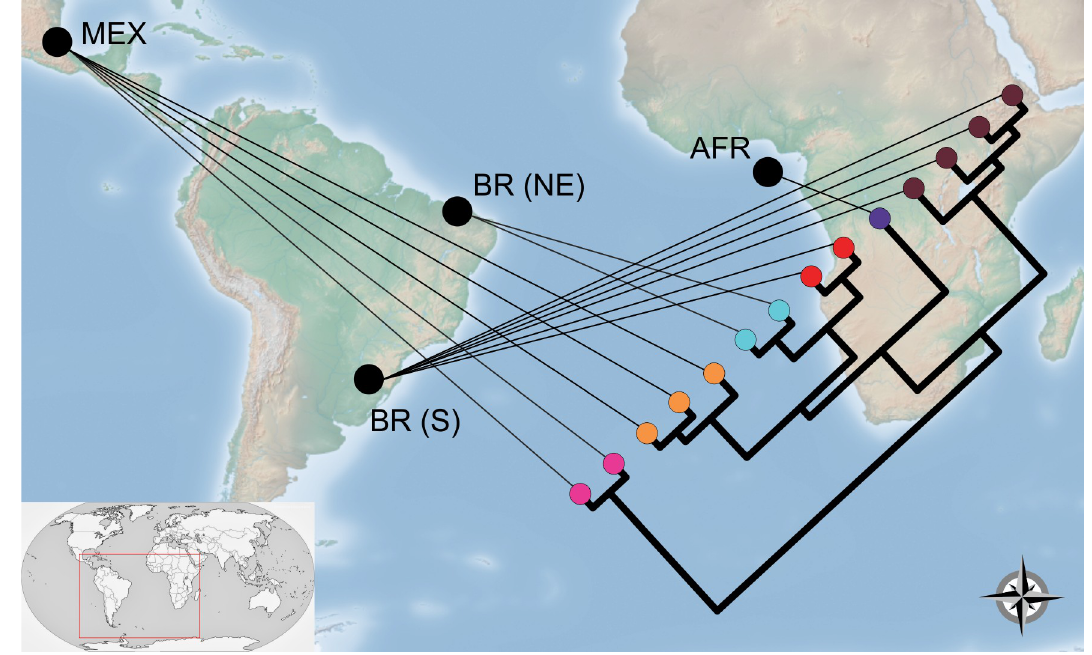
Fig 3. Geophylogeny proposed for Blumenavia . In nodes: pink Blumenavia toribiotalpaensis ; orange B . heroica sp. nov.; blue B . baturitensis sp. nov.; red B . rhacodes ; purple B . angolensis ; brown B . crucis-hellenicae sp. nov.